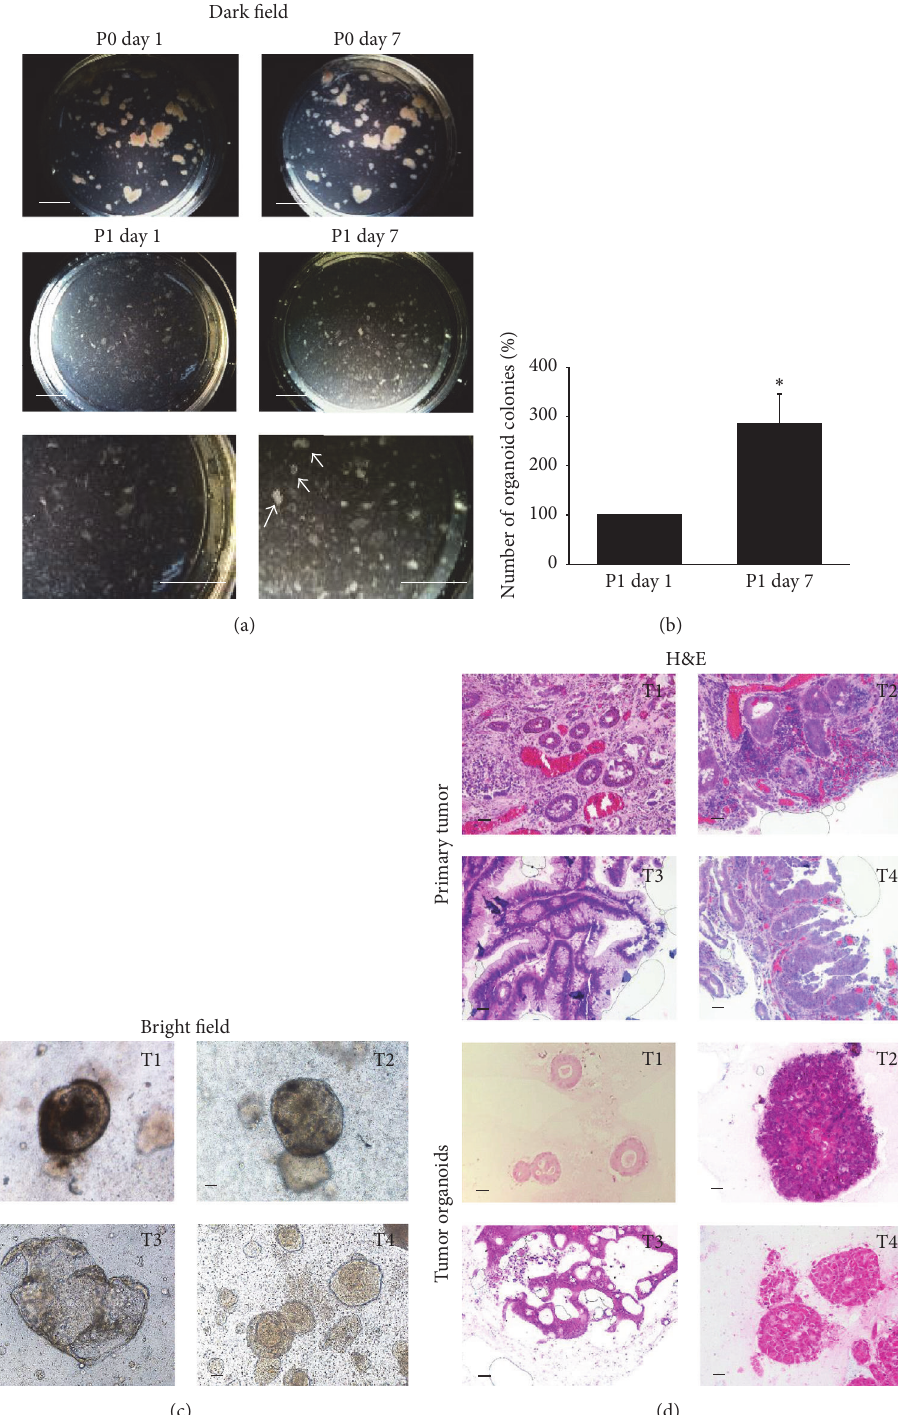
Figure 2: Generation of human ALI tumor colorectal organoids. Human tumor colon tissue fragments were seeded in collagen gels under an ALI microenvironment and cultured in ISCs media. Pictures were taken at days 1 and 7 after seeding tissues and at days 1 and 7 after passage (b). Scale bar: 5 mm. Enlarged pictures of postpassage are shown under the original pictures at passage 1. Arrows show the grown-up organoids. The number of organoid colonies was counted ((c), n = 4). ∗ 𝑃 < 0.05 versus passage 1 day 1. Representative phase contrast images of human ALI tumor colorectal organoids from four patients (T1, T2, T3, and T4) are shown (c). Scale bar: 200 𝜇 m. H&E staining of primary tumors and the tumor organoids from four patients (T1, T2, T3, and T4) are shown (d). Representative photomicrographs were shown ( n = 4). Culture days 14–21. Scale bar: 100 𝜇